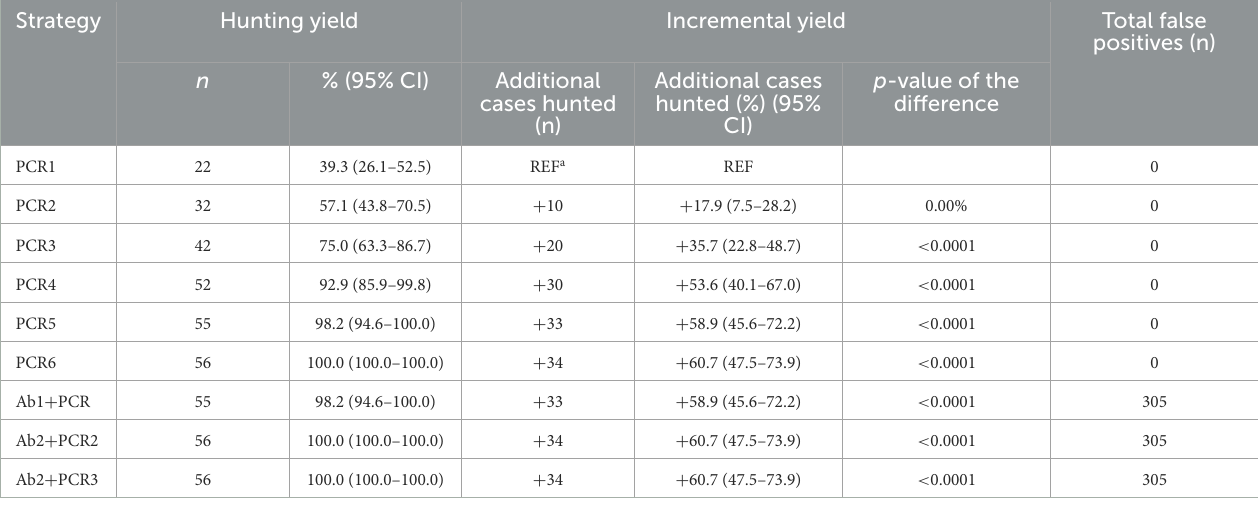
TABLE 3 Hunting yield, incremental yield, and number of false positives obtained with different algorithms.